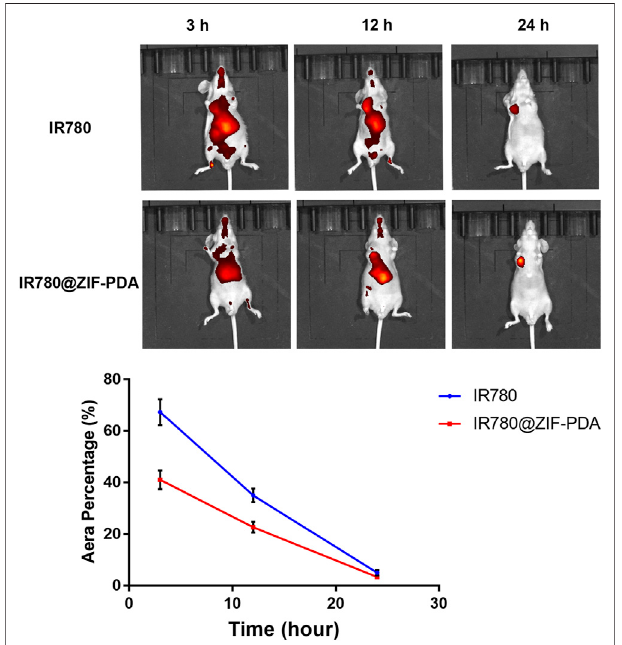
FIGURE5| Invivo imagingmiceat 3,12,and24 hafter tailveininjection of IR780 and IR780/ZIF-PDA, respectively.